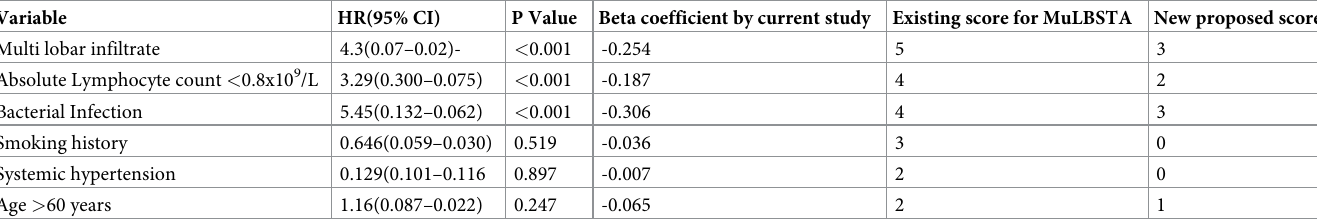
Table 4. Calculations of the MuLBSTA score for risk stratification in the validation